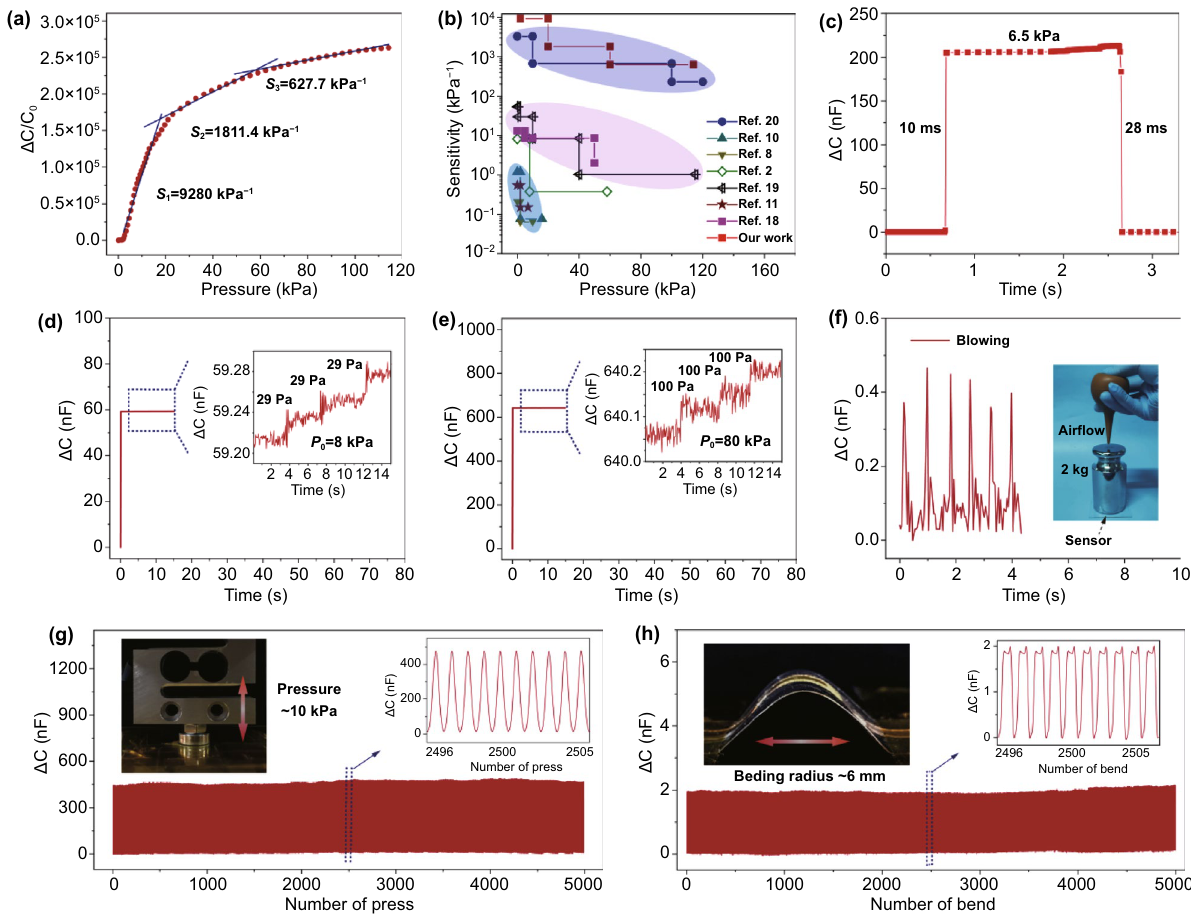
Fig. 4 Sensing performances of the PU-IL foam-based capacitive pressure sensor. a Sensitivity of the sensor at pressure range up to 114 kPa. b Comparison of the sensitivity of our device with previously reported results. c Response time of the pressure sensor. Detection of weak pressure at preload pressure of 8 kPa (panel d ) and 80 kPa (panel e ). f Capacitance response of our sensor to airflow under a basic pressure of 127 kPa from 2 kg weight. g Compression-release stability over 5000 cycles under a peak pressure of 10 kPa. h Bend-release stability over 5000 cycles to a bending radius of ~ 6